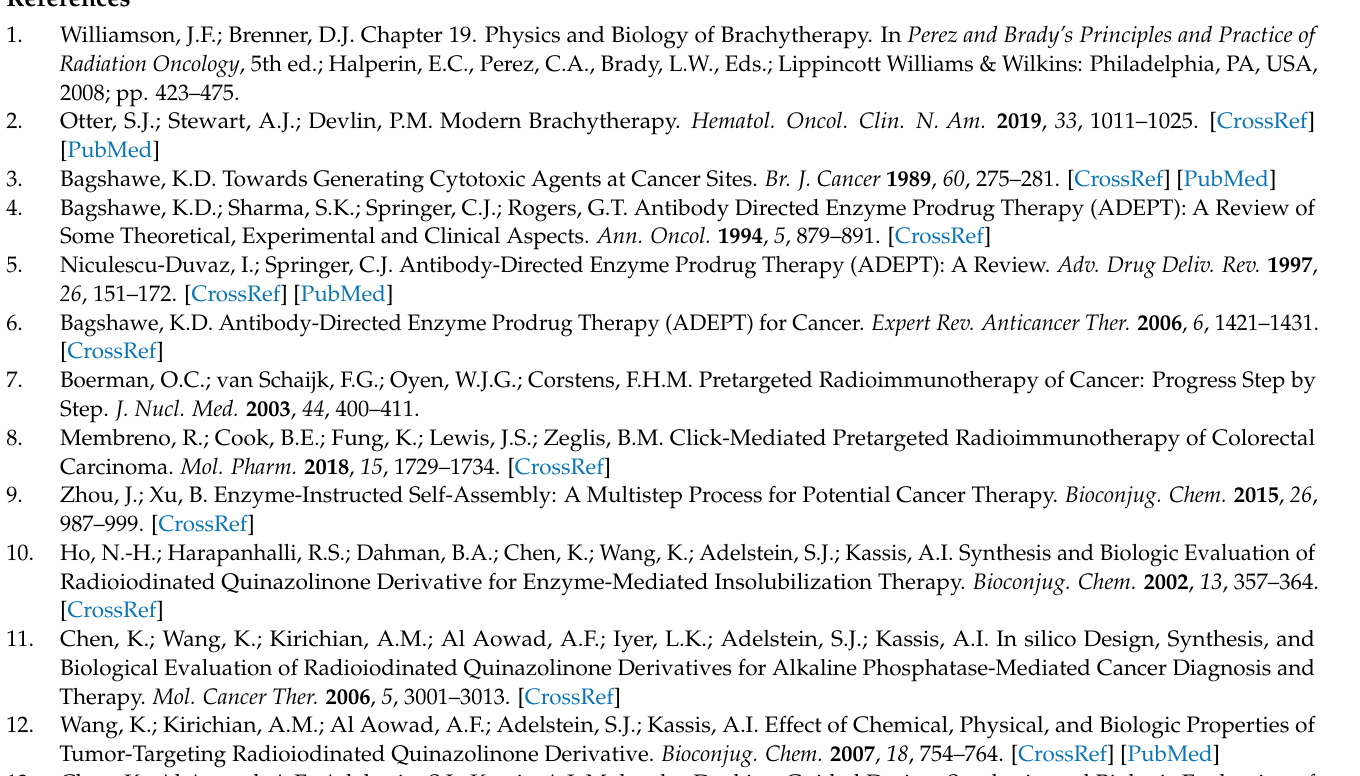
Figure A3. Visualization (UV illumination) over time upon enzymatic treatment (100 nM enzyme) under physiological conditions of 18 (top row), 19 (middle row), and 19-I 2 (bottom row). Each sample was at 20 μ M (left member of each pair: PDE treatment; right member of each pair: ALP treatment).